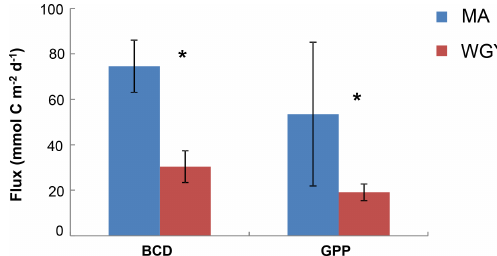
Figure 2. Integrated stocks of bacterial carbon demand (BCD) and gross primary production (GPP) (mmolCm − 2 day − 1 ) over the eu- photic zone. Data from Van Wambeke et al. (2018). Error bars correspond to standard deviation of the different stations. ∗ BCD and GPP were statistically different between MA and WGY areas (Mann–Whitney test, p < 0 .